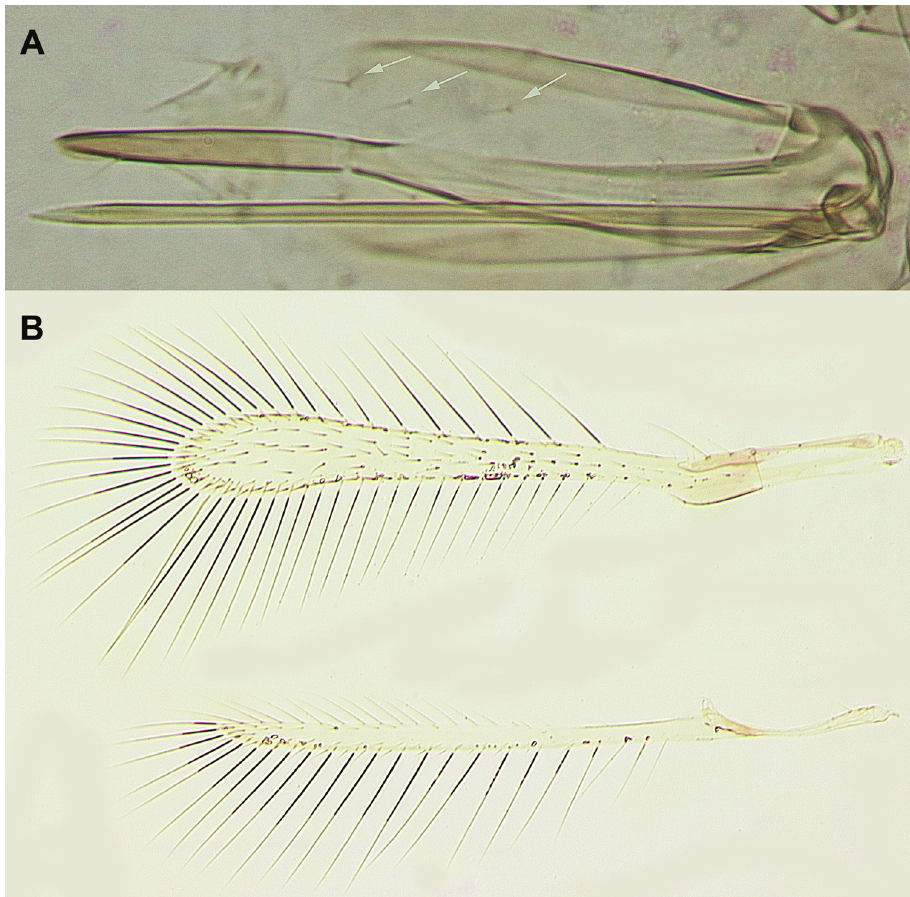
Figure 2. Anagrus dmitrievi (female, holotype): A ovipositor (arrows pointing to distal setae on one of its external plates, or second valvifers) B fore and hind